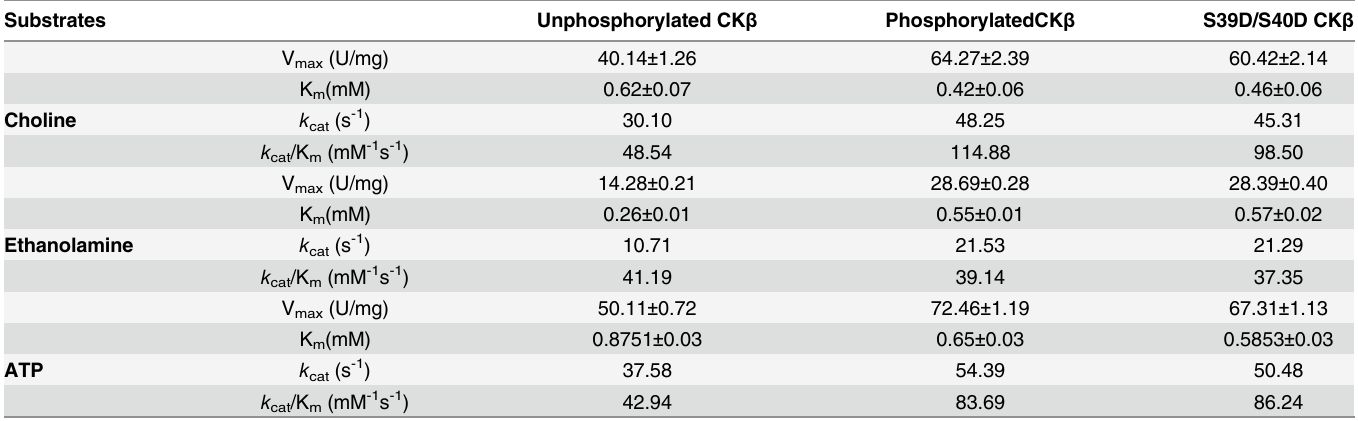
Table 2. Kinetic parameters of unphosphorylated CK β , phosphorylated CK β , and phosphorylation-mimic mutant of CK β . The values ( ± SEM) of V max and K m were obtained from triplicate measurements. All activities were determined by the standard PK-LDH-dependent coupled-enzyme assays as described in the experimental procedures. For the ATP data, the phosphoryl acceptor substrate was choline at 4 mM concentration.